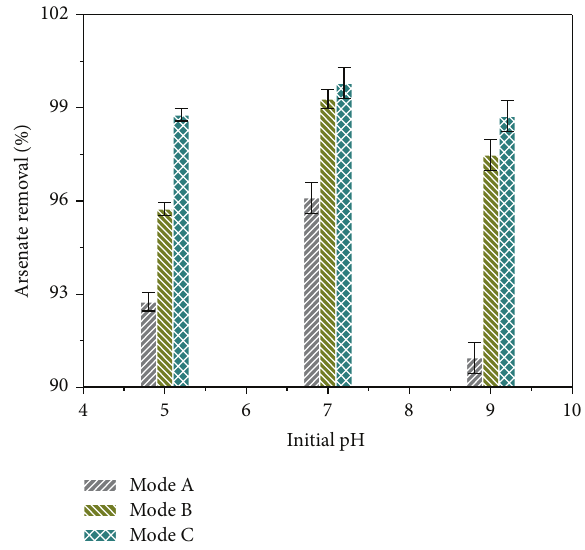
Figure 2: Arsenic removal efficiencies in different dosing modes. (Mode A: single-step dosing; Mode B: two-step sequential dosing; Mode C: three-step sequential dosing).